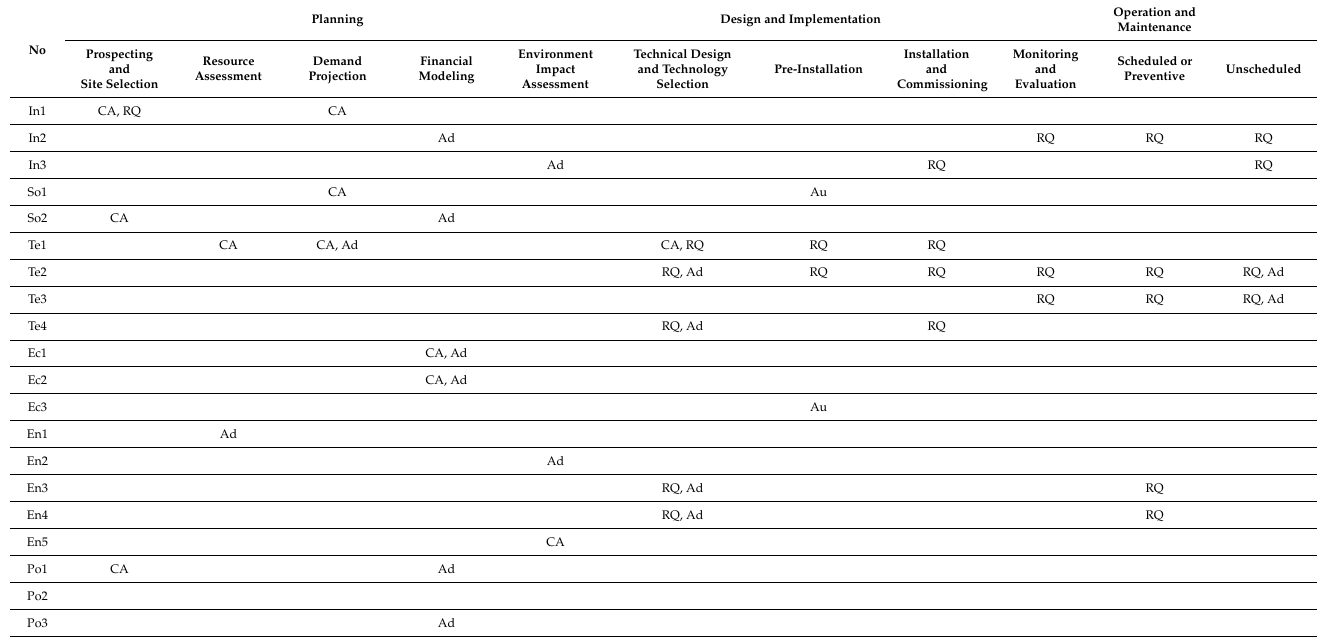
Table 4. Potential scaling and sustainability challenges and the impact on the energy access attributes at each development phase. Challenges: institutional (In), social (So), technical (Te), economic (Ec), environment (En), policy (Po); Energy access attributes: capacity and availability (CA), reliability and quality (RQ), affordability for developers (Ad), and affordability for users